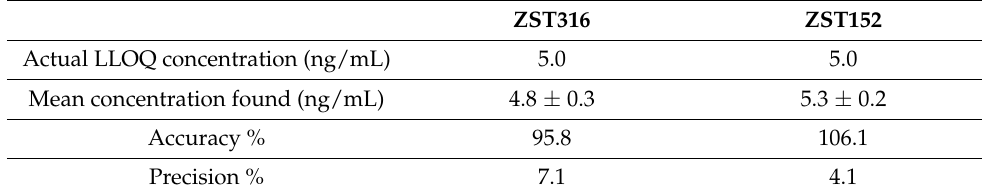
Table 1. LLOQ of ZST316 and ZST152 in plasma.